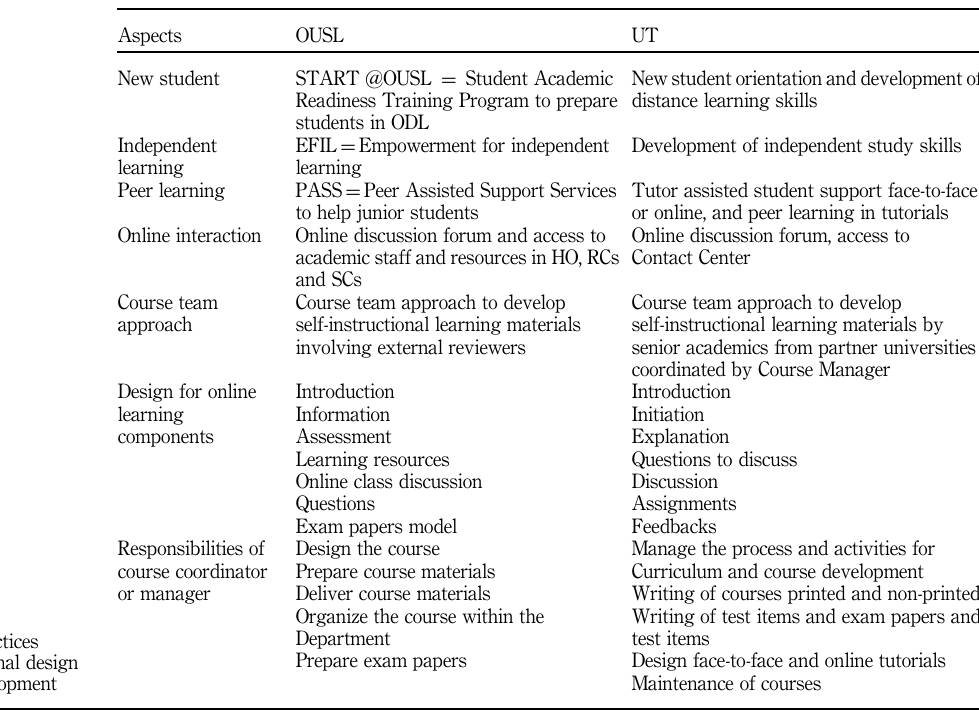
instructional design and